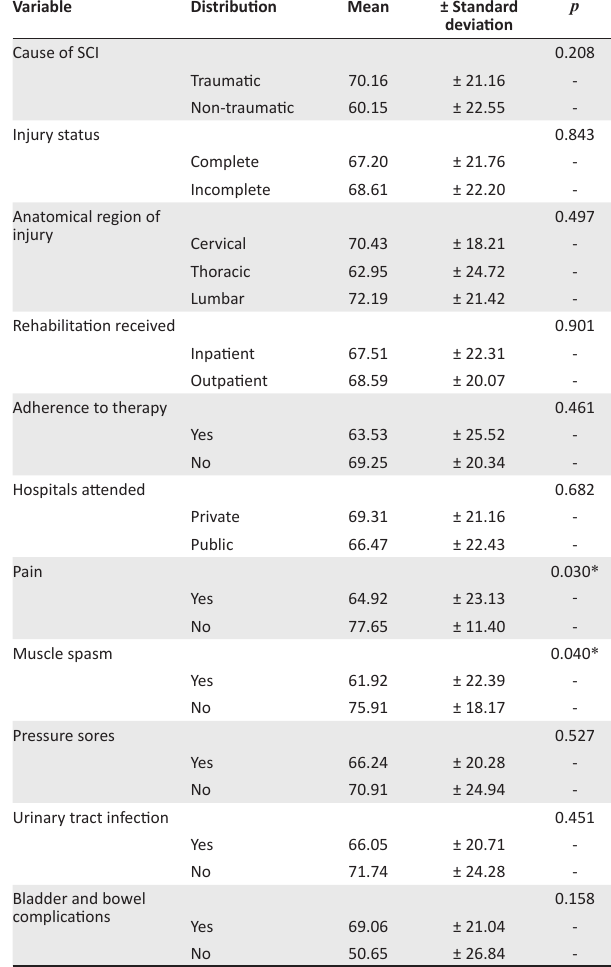
TABLE 2: Aetiology, type of injury, rehabilitation and secondary complication of participants ( n = 41). Variable